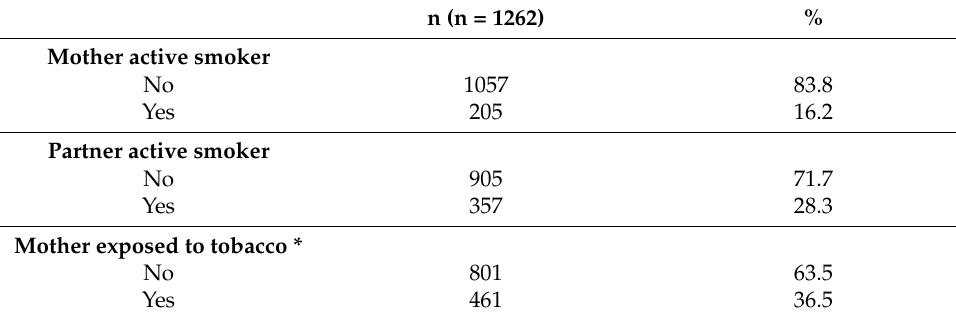
Table 1. Environmental exposure to tobacco smoke.